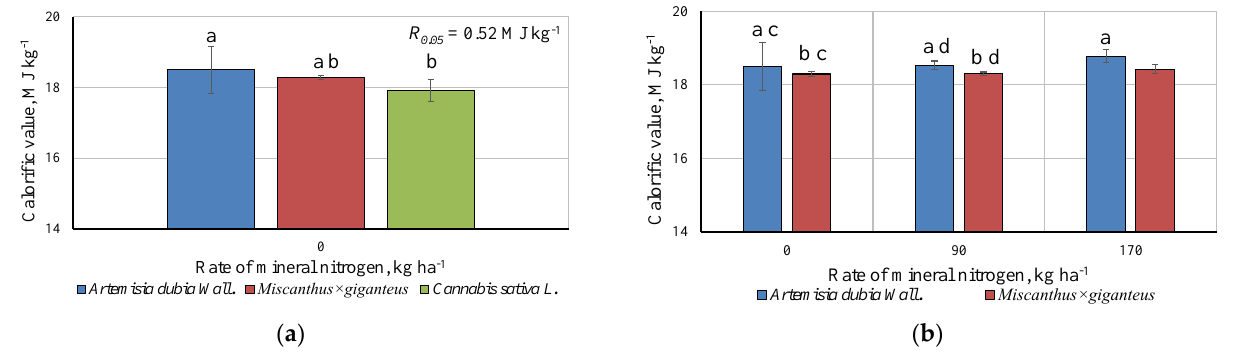
Figure 3. The dependence of the calorific value of above-ground crops of Artemisia dubia Wall., Miscanthus × giganteus and Cannabis sativa L. not fertilized ( a ), on mineral nitrogen fertilization ( b ) ( R 0.05 ( A. dubia ) = 0.55 MJ kg −1 , R 0.05 ( M. giganteus ) = 0.12 MJ kg −1 , R 0.05 ( A. dubia × M. giganteus ) = 0.12 MJ kg −1 . a, b, c, d, there are no statistically significant differences ( p < 0.05) between the columns marked with the same letter, as assessed using the least significant difference.